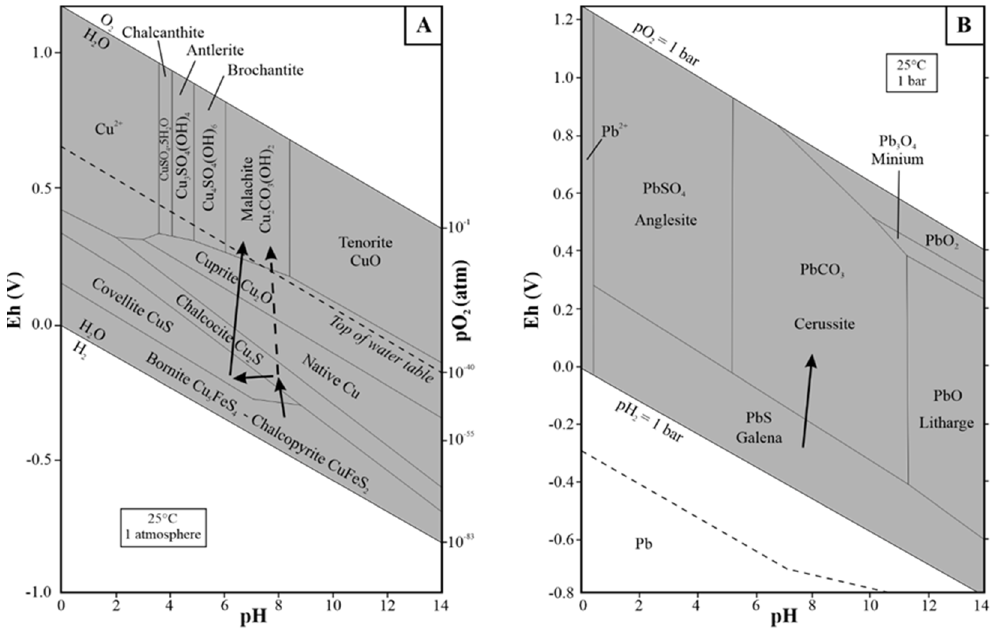
Figure 7. ( A ) Eh-pH diagram of the system Cu-C-S-Si-O-OH showing stability fields of Cu-minerals at 25 °C and 1 atm (modified from reference [53]); ( B ) Eh-pH diagram of the system Pb-S-C-O-OH showing the stability fields of Pb-minerals at 25 °C and 1 bar (modified from reference [54]).